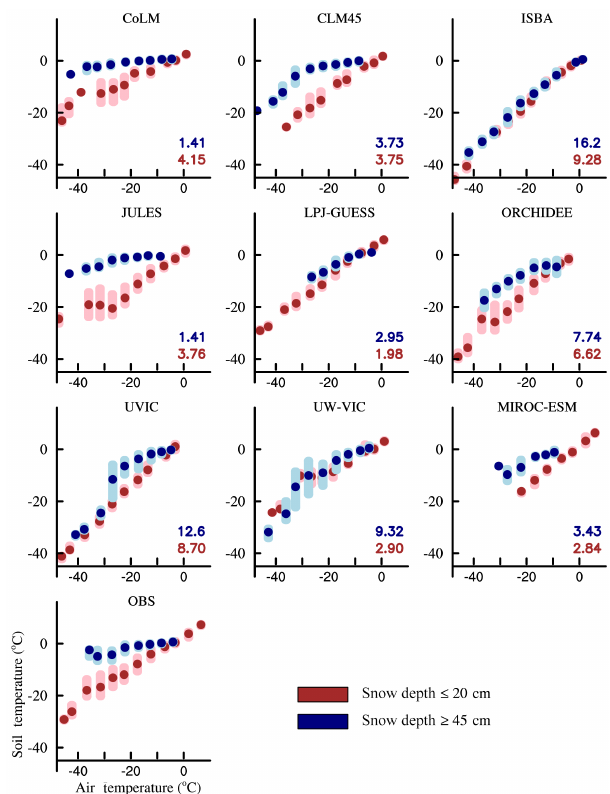
Figure 4. Variation of soil temperature at 20cm depth ( ◦ C) with air temperature ( ◦ C) for winter 1980–2000. The dots represent the medians of 5 ◦ C air temperature bins and the upper and lower bars indicate the 25th and 75th percentiles, calculated from all Russian station grid points ( n = 268) and 21 individual winters. The num- bers in each model panel indicate the RMSE between the observed and modelled relationship. Colours represent different snow depth regimes.